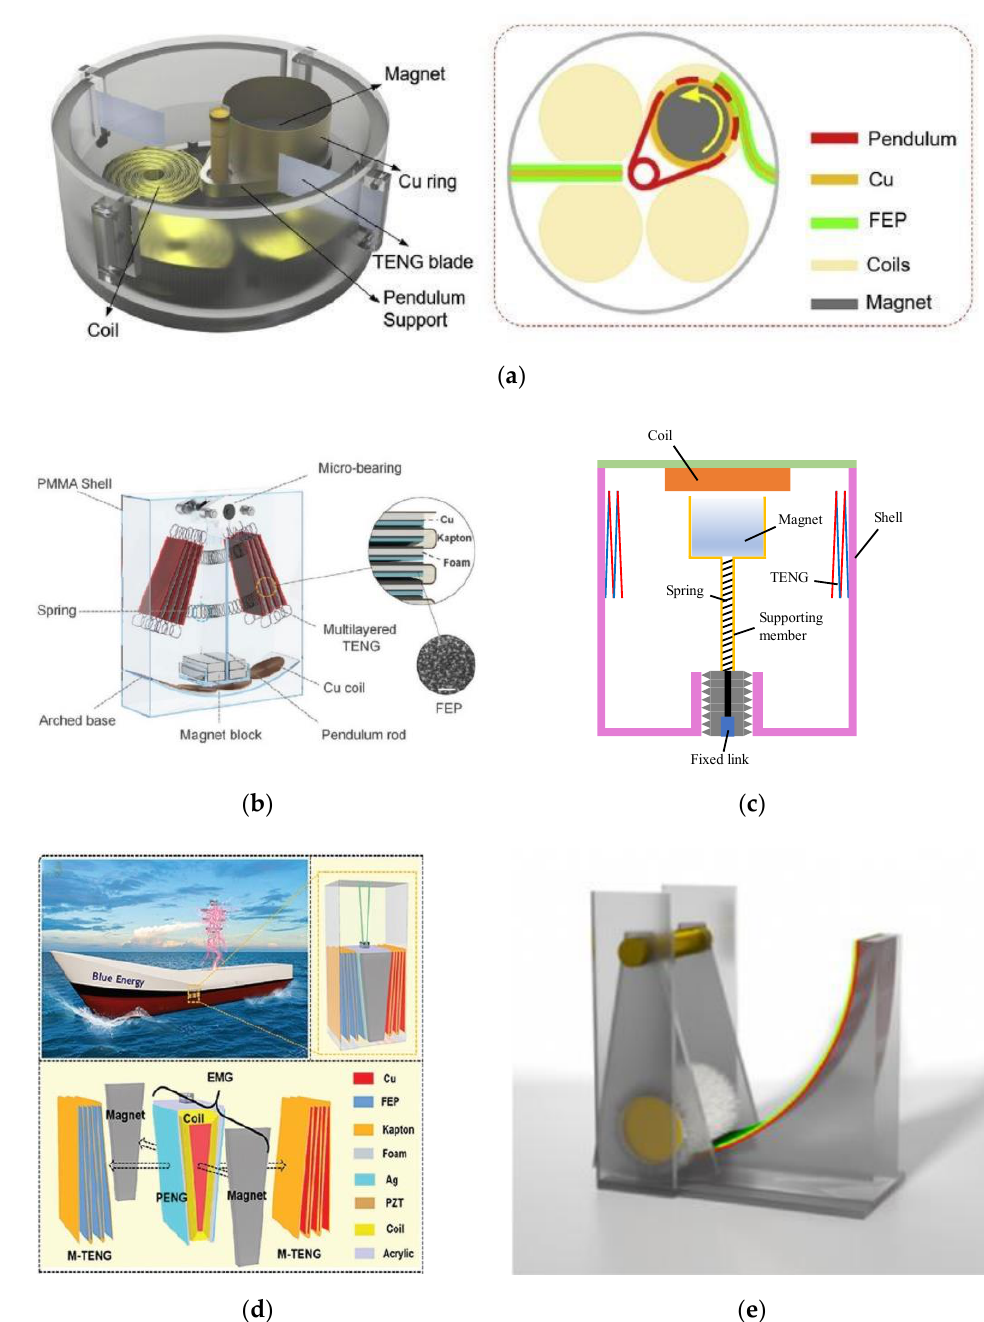
Figure 14. ( a ) Rotational pendulum hybrid energy harvester [102]. Adapted with permission from